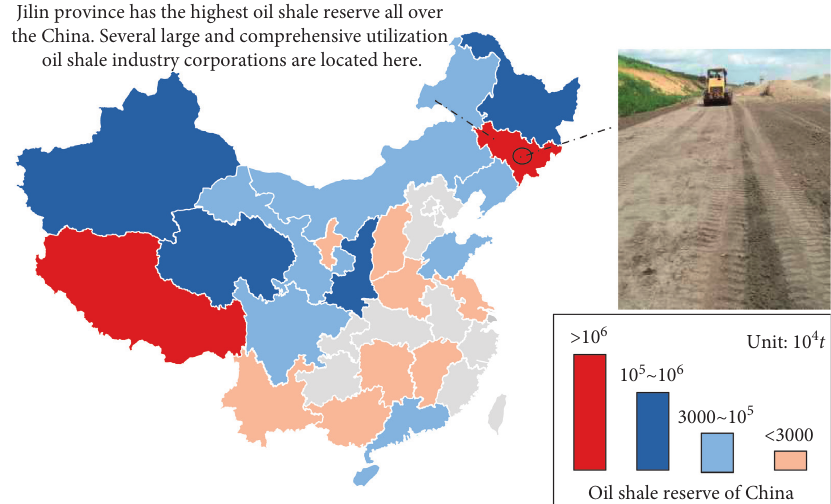
Figure 1: Distribution of oil shale resources in